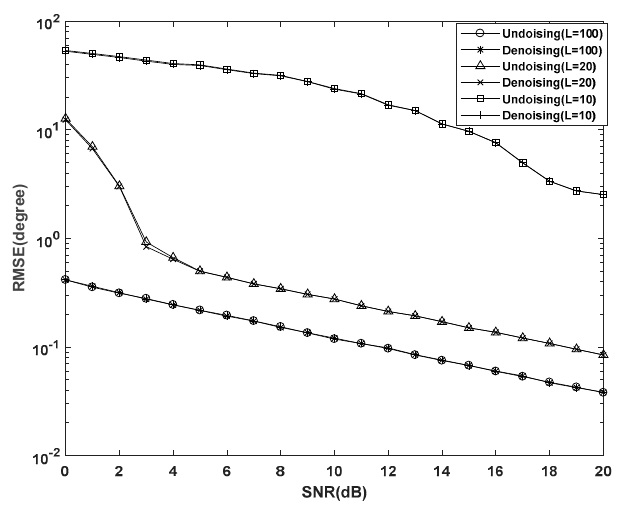
Figure 5. Effects of omitting the noise on root mean square error (RMSE) performance. Figure 5. E ff ects of omitting the noise on root mean square error (RMSE) performance.